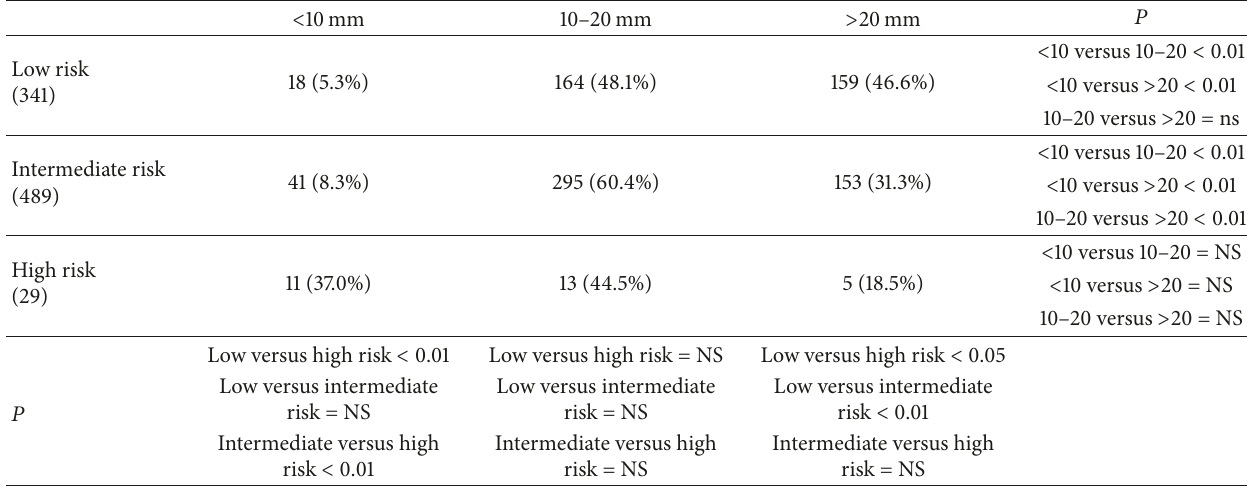
Table2:Thegreaterdiametersofthyroidnodulesevaluatedbyfineneedleaspiration,dividedbyultrasoundriskcategories.Dataareexpressed as the mean ±